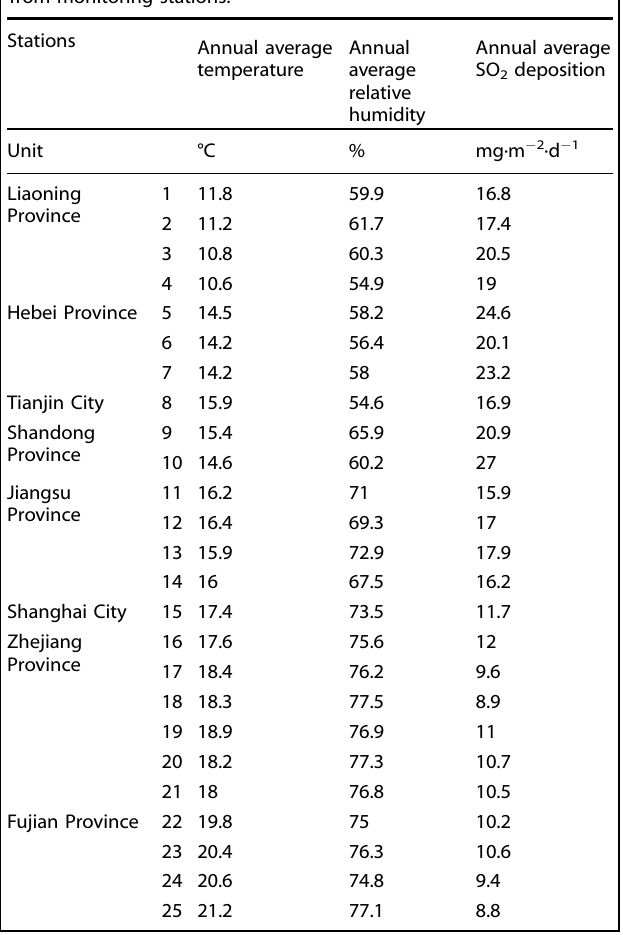
Table 2. The annual average values of corrosion factors collected from monitoring